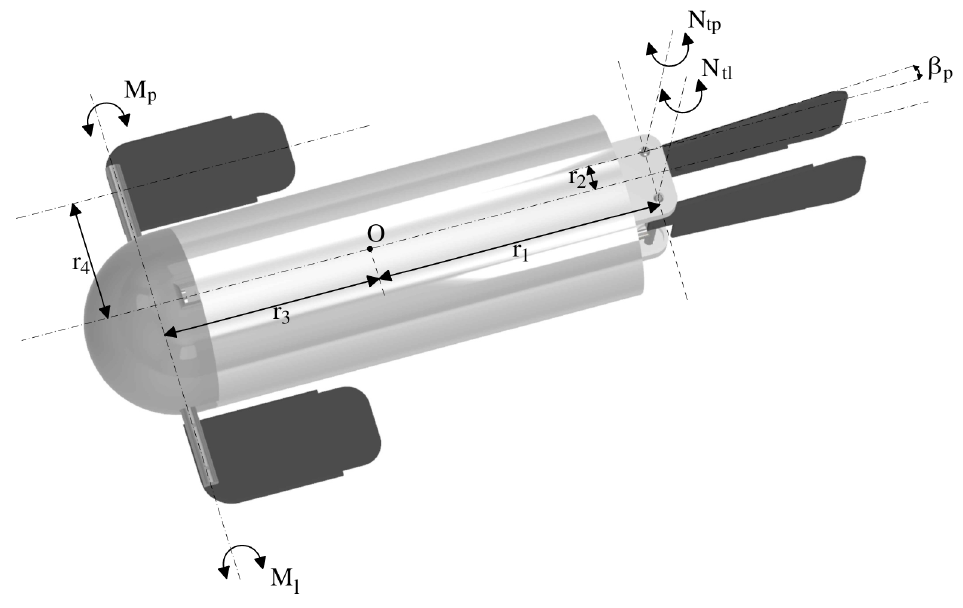
Figure 2. Mini CyberSeal propulsion model [own